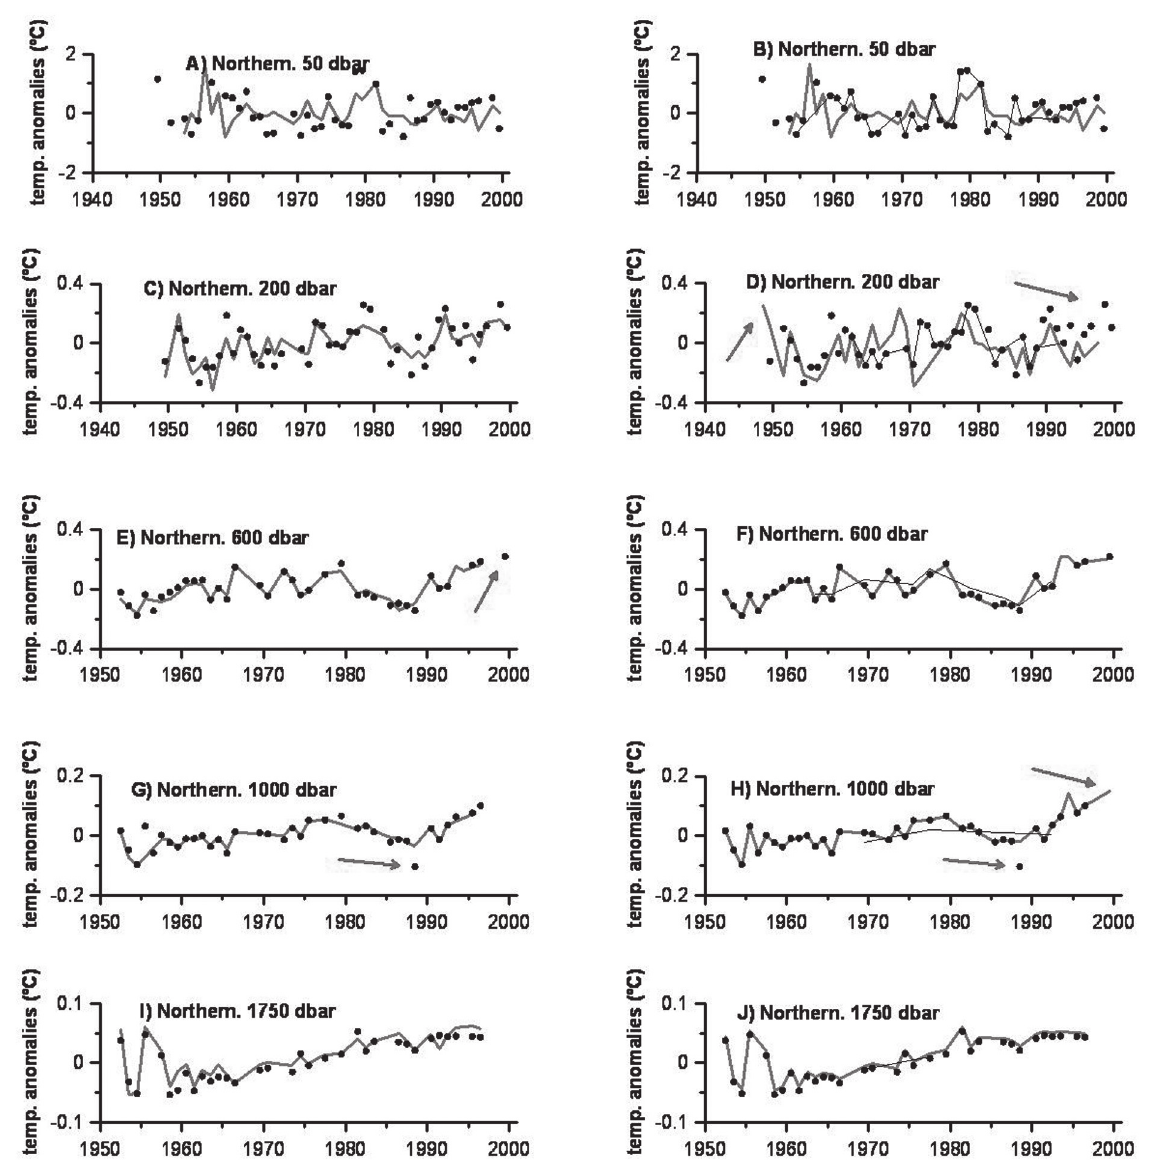
Fig . 4. – in both the left and right column we include the yearly averaged temperature after a mean value for the 1960-1990 period has been subtracted (case 1 in the text). in the left column, (Figures a, c, e, g and i), grey lines are time series of residuals or anomalies. We first get a time series of monthly anomalies by subtracting a climatological seasonal cycle (case 2) and then we obtain a yearly average of these residuals for comparison with case 1. The right column (Figures b, D, F, H and J) shows time series of residuals (grey line), which are a mixture between cases 1 and 2. a monthly climatological cycle is used for levels above 200 dbar, and a mean value for the period 1960-1990 is used from 200 dbar to the bottom (case 6). The thin black line is a series of yearly averages in which only years containing data for all the seasons of the year have been considered as valid ones. arrows indicate data points which can induce differences in trend